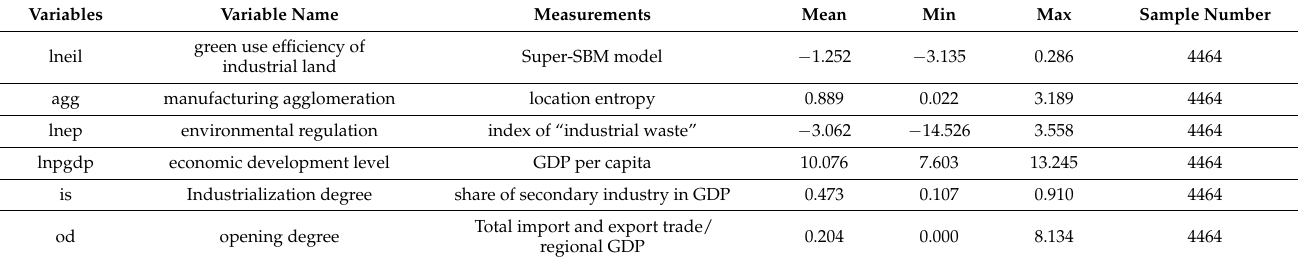
Table 2. Descriptive statistics